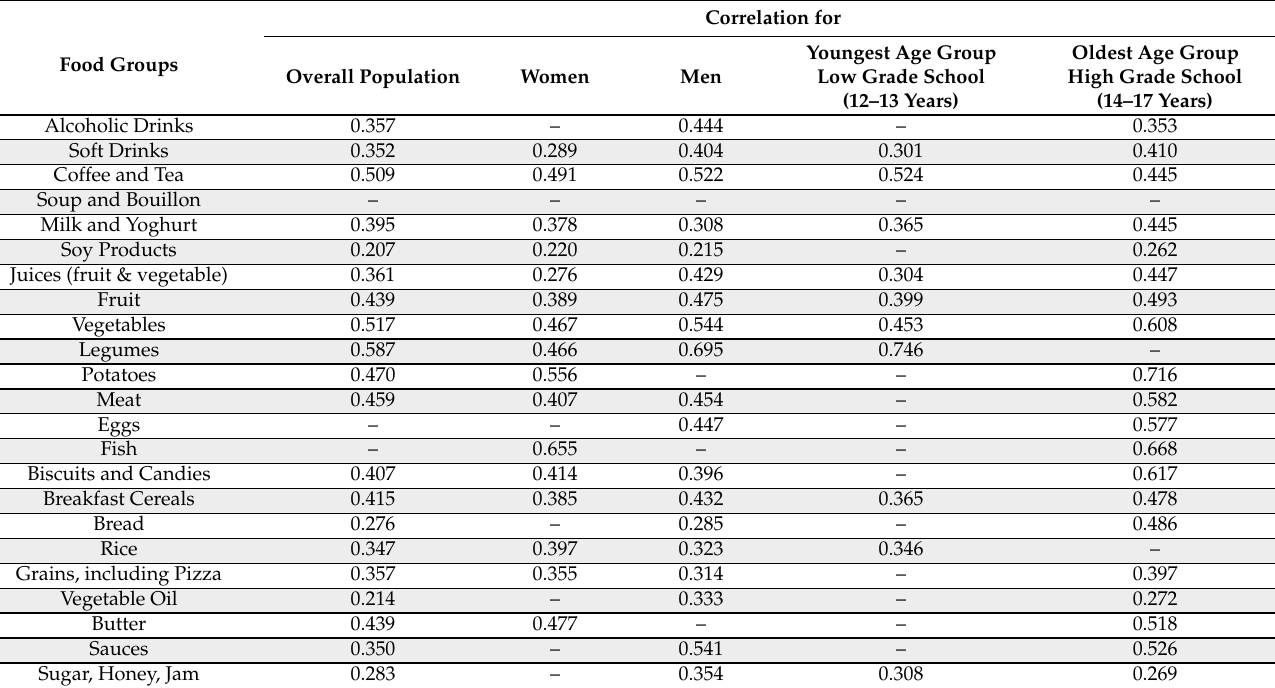
Table 2. Spearman correlations corrected for within person variability of 3-day diaries; n =